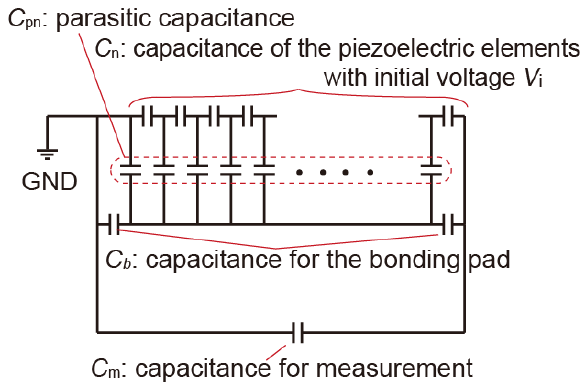
Figure 6. Equivalent-circuit model of series-connected piezoelectric elements. The piezoelectric elements are modeled as simple capacitors with initial voltages.